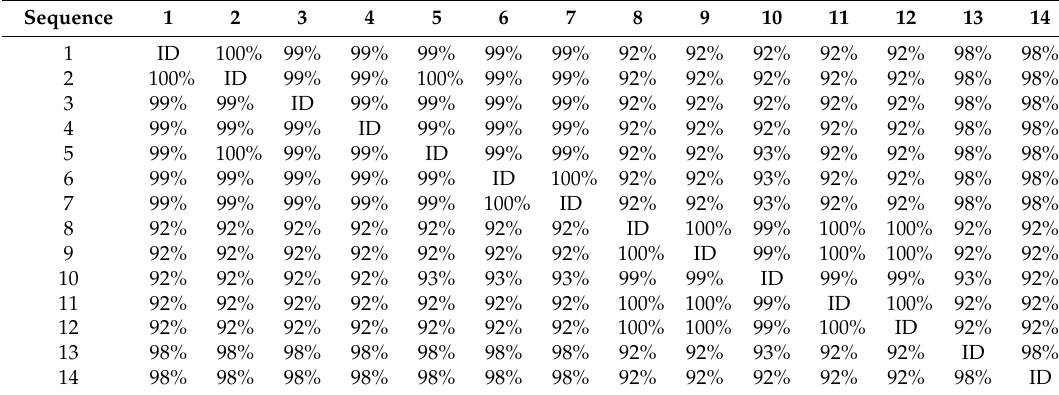
Table 3. Percentage nucleotide identity among reported viruses in this